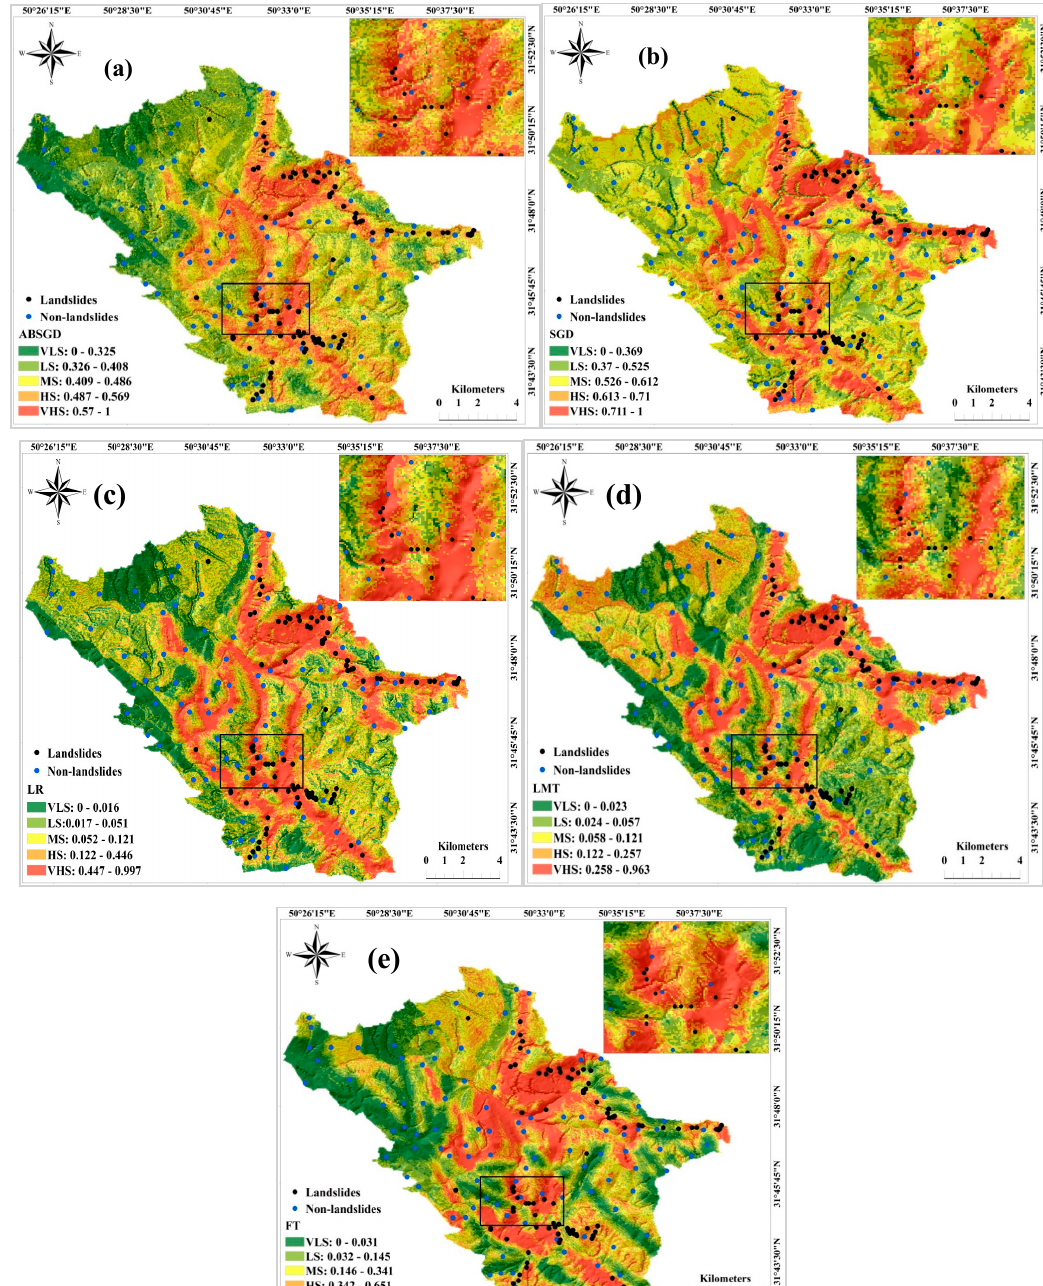
Figure 5. Landslide susceptibility maps using: ( a ) AdaBoost-scholastic gradient descent (ABSGD); ( b ) stochastic gradient descent (SGD); ( c ) logistic regression (LR); ( d ) logistic model tree (LMT); and ( e ) functional tree (FT).